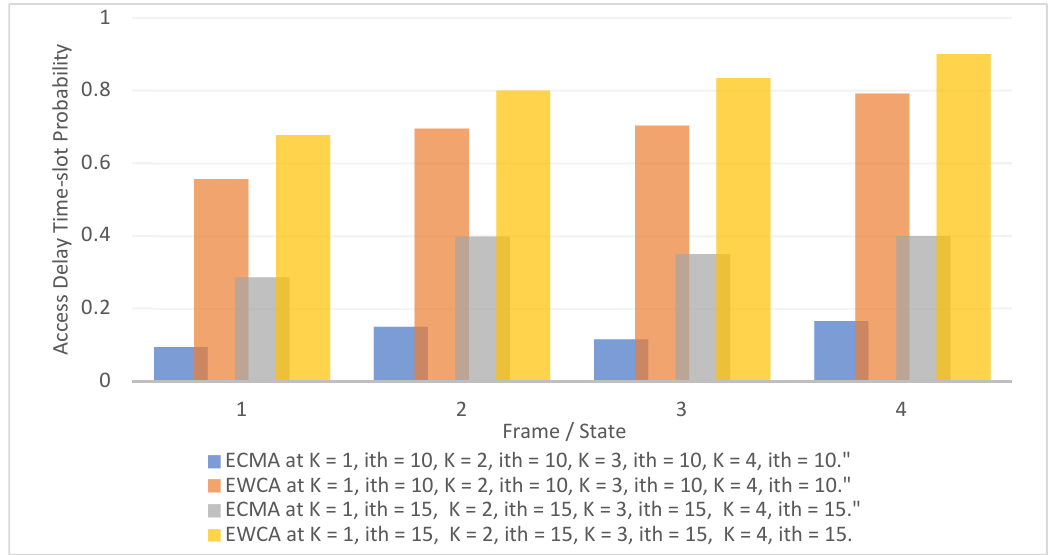
Figure 6. Access delay at various state.